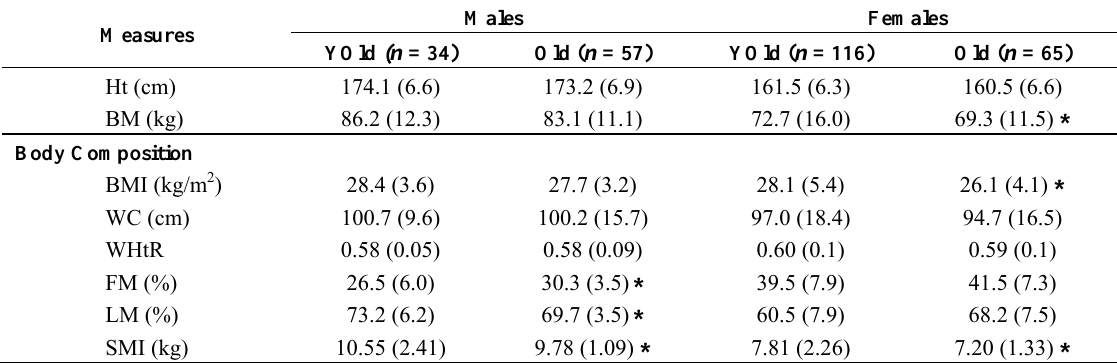
Table 3. Participant characteristics, body composition, cardiovascular/bloods, flexibility/strength, and PASE and SCREEN scores, of older community-dwelling older adults separated into sex and age